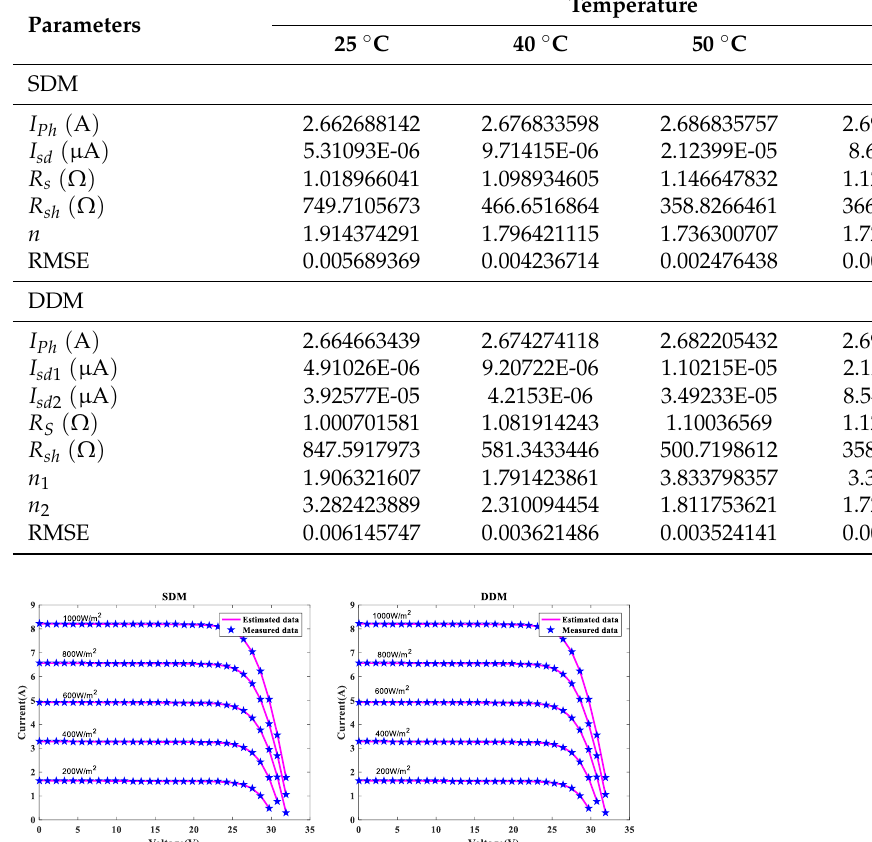
Table 19. Optimal parameters with various temperatures under 1000 irradiance on ST40.